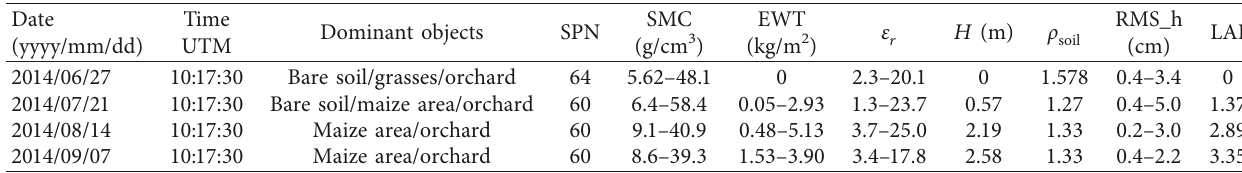
Figure 1: Location of the study and the four experiments. Table 1: Radarsat-2 and in situ